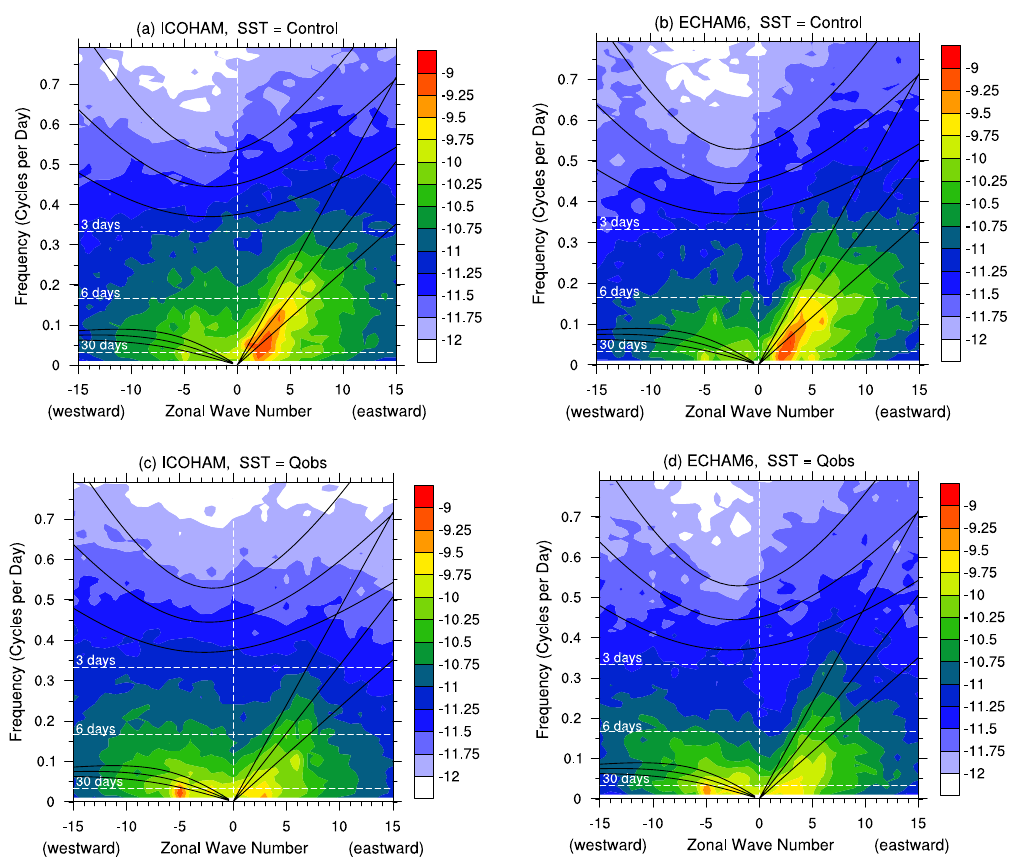
Fig. 15. Wavenumber-frequency diagrams of tropical precipitation (meridionally averaged between 10 ◦ S–10 ◦ N) in aqua-planet simulations carried out with ICOHAM at R2B4L31 (left column) and ECHAM6 at T63L31 (right column). The color shading shows the logarithm of the power of the symmetric component of the unnormalized spectra, diagnosed using the methodology of Wheeler and Kiladis (1999). The black lines indicate the dispersion relationships of westward propagating equatorial Rossby waves, eastward propagating Kelvin waves, and inertia-gravity waves that can propagate either westward or eastward. The upper row shows results corresponding to the “Control” SST profile. The lower row corresponds to the “Qobs” profile. Further details can be found in Sect.